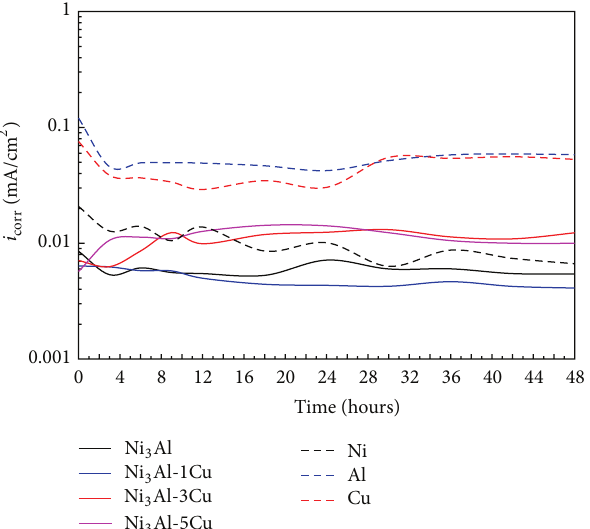
Figure 16: 𝐼 variation against time for the tested materials. corr values of EIS Determined from the 𝑅 ct